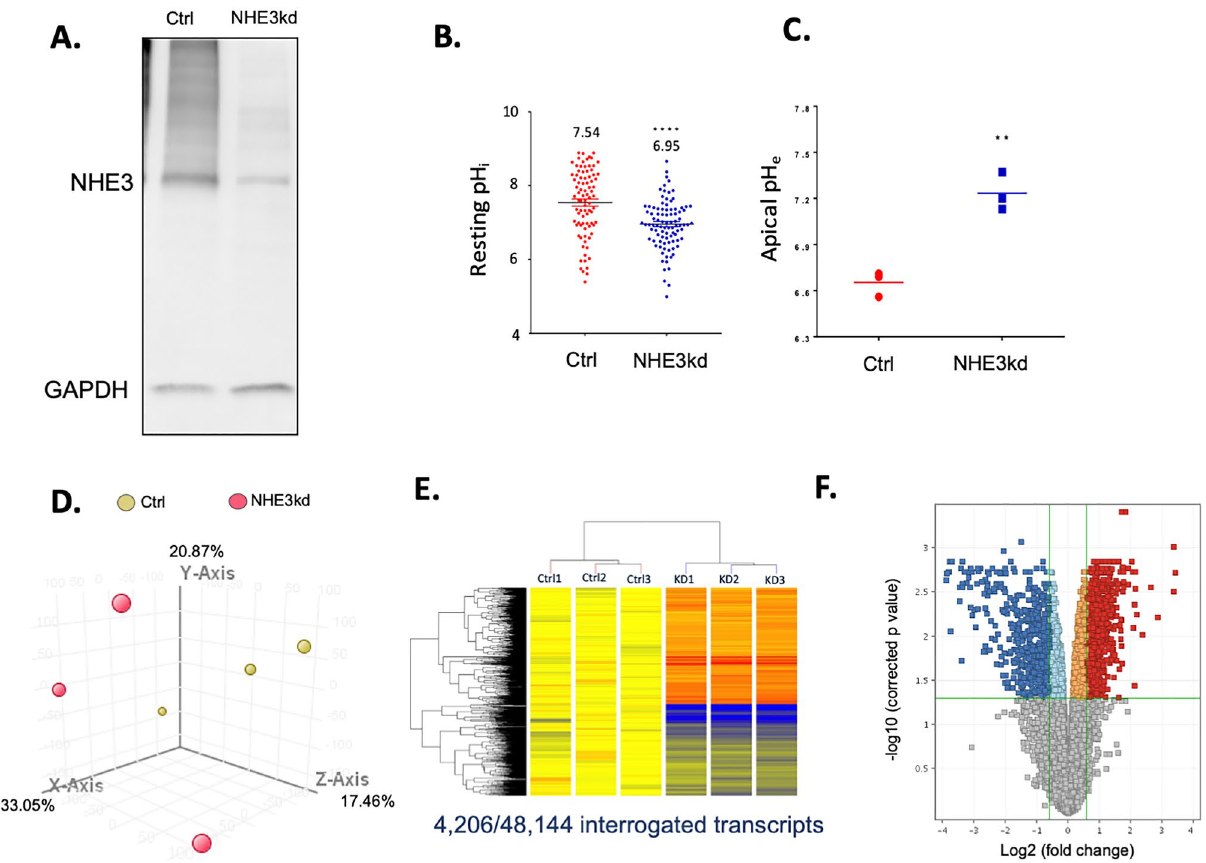
Figure 5. The effects of NHE3 knockdown in SK-CO15 colonic adenocarcinoma cells on cellular pH and gene expression profile. ( A ) Representative Western blot of NHE3 protein expression in control (Ctrl) or NHE3- knockdown cells (NHE3kd) stably transduced with lentivirus with scrambled or NHE3-specific shRNA. Full blot shown in Supplementary Fig. S7. ( B ) Decreased resting intracellular pH (pHi) in NHE3kd cells (Student t-test, ****p < 0.0001). ( C ) Increased extracellular apical pH (pHe) in NHE3kd cells grown as monolayers in Transwells (Student t-test, **p < 0.01). Differences in global gene expression profile of Ctrl and NHE3kd cells determined by microarray analysis: ( D ) Principal component analysis of samples without filtering; ( E ) heat map of differentially expressed 48,144 transcripts; ( F ) Volcano plot of differentially expressed genes in Ctrl vs. NHE3kd cells. ( D – F ) generated by GeneSpring GX software (https:// www. agile nt. com/ en/ produ ct/ softw are- infor matics/ genom ics- softw are- infor matics/ gene- expre ssion/ genes pring-